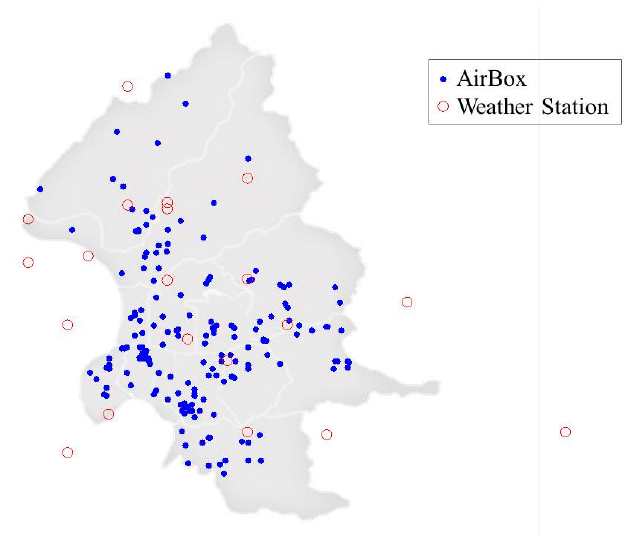
Figure 7. Distribution of AirBoxes and weather stations in or around Taipei.